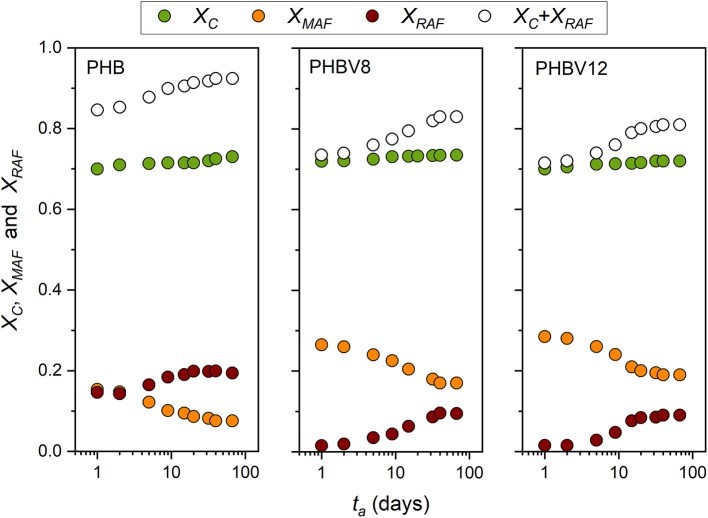
Time evolution of the crystalline weight fraction (XC), mobile amorphous weight fraction (XMAF), rigid amorphous weight fraction (XRAF), and total solid fraction (XC+ XRAF) of PHB, PHBV8 and PHBV12 as a function of the storage time (ta) at Troom (estimated errors: ±0.02 for XC and XMAF, ±0.04 for XRAF).